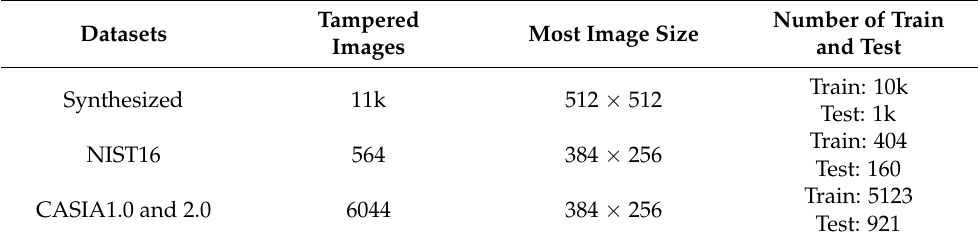
Table 1. Comparison of image